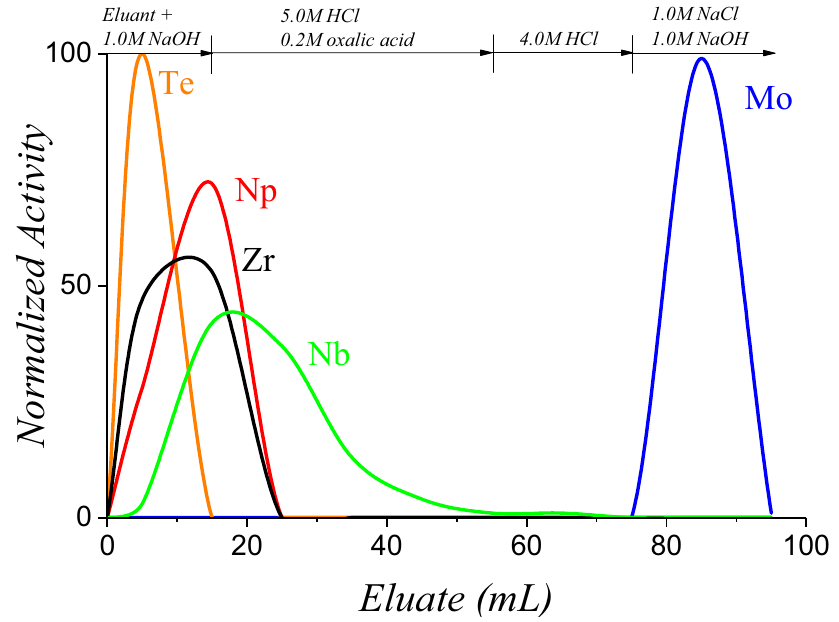
Figure 5. Elution profile of Zr, Np, Te, Nb, and Mo on an anion exchange resin. The feed solution was derived from the irradiated uranyl sulfate target MoLLE raffinate. Column dimensions: 1.0 g AG-MP1 in a 10 cm × 1 cm ID support; flow rate ≈ 2 mL/min.